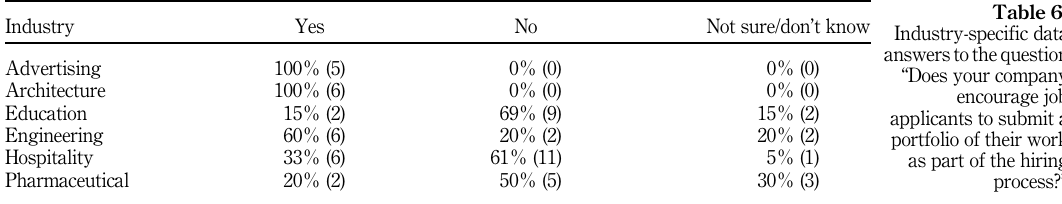
Table 6. Industry-specific